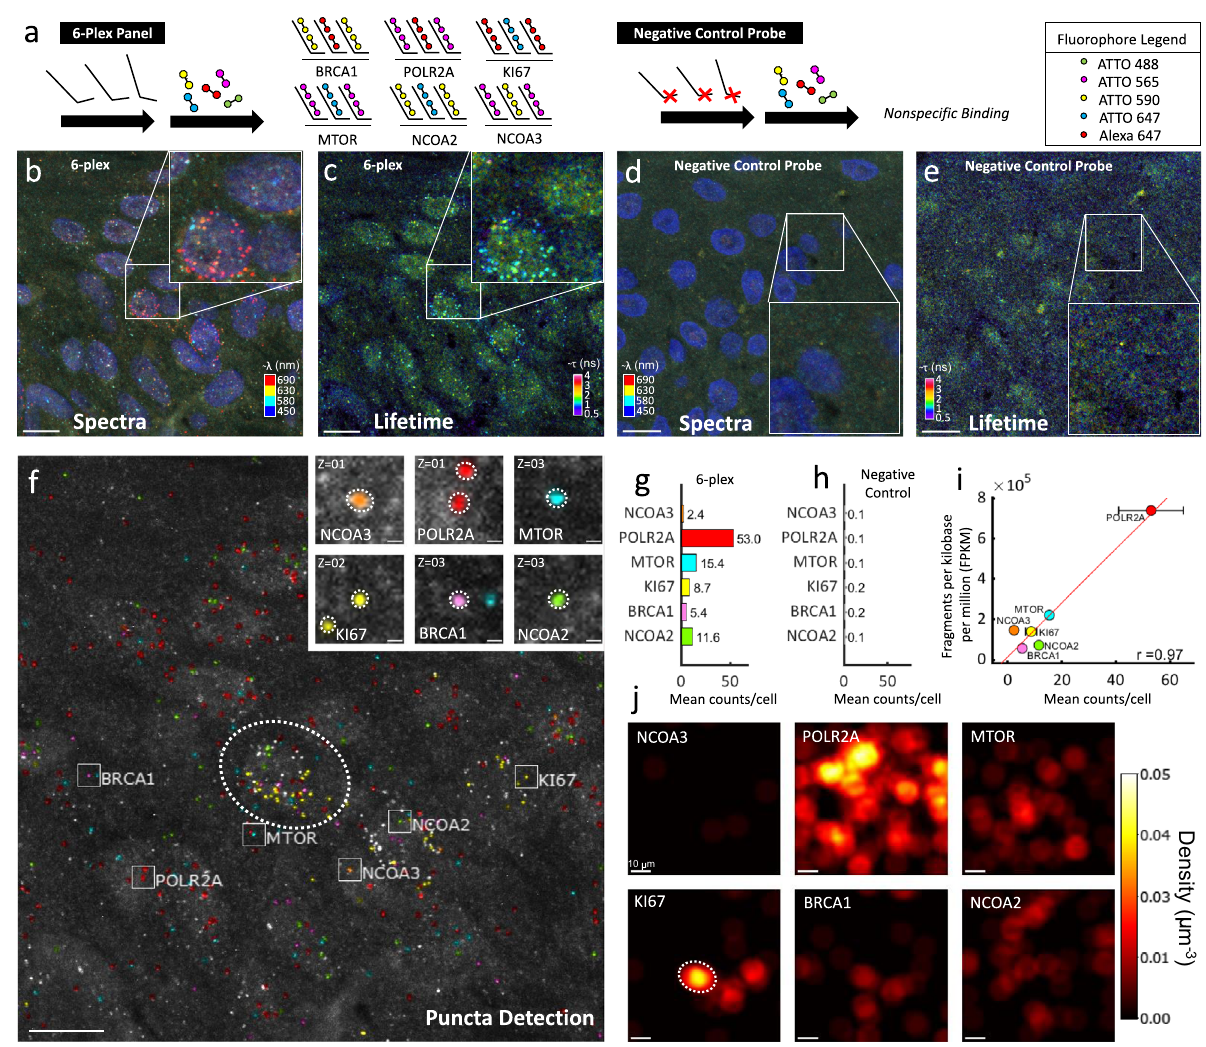
Fig. 5 Multiplexed mRNA detection in epidermis region of human skin melanoma FFPE tissue. a 6 different types of gene transcripts were labeled with primary probes followed by respective and complementary fl uorescent secondary probes. Each transcript was labeled with a combination of two different fl uorophores for six combinations. Negative control probes targeting transcripts not present in the sample were used with their respective secondary fl uorophore probes. b Spectral image (max-projection in z) of a fi eld of view of the labeled 6-plex sample (three channel pseudo coloring). c Lifetime image (max-projection in z) of a fi eld of view of the labeled 6-plex sample (phasor projection on universal circle pseudo coloring). d Spectral image of the labeled negative control probe sample is depicted. e Lifetime image of the labeled negative control probe sample. f Final puncta detection of the 6-plex fi eld of view after being processed in our analysis software showing highlighted example puncta of each target (insets, right). g Mean puncta counts per cell of transcripts for each gene in the 6-plex sample ( n = 2 experimental replicates, 174 cells). h Puncta count for the negative control probe sample ( n = 2 experimental replicates, 375 cells). i Correlation of detected puncta (mRNA puncta count) vs. bulk sequencing (fragments per kilobase per million) is shown for each target. j Transcript density in the fi eld of view for each of the expressed genes reveals clustering of speci fi c genes, as an example KI67 appears highly expressed in three cells, one of them marked with a dotted ellipse that corresponds to location in f ). Scale bars 10 µ m in large images and 1 µ m in insets. Source data are provided as a Source Data fi spectral and lifetime images of the corresponding negative probe sample also in the epidermis region. Figure 5f depicts the pseudo- colored puncta which were successfully classi fi ed and identi fi ed as their assigned mRNA markers. A representative inset image for each marker and its targeted detection is provided on the right. We observed that a population of puncta consisting of nonspeci fi c, auto fl uorescent, or unknown sample artifacts rejected from analysis, (1,100) or 37.5% of the total detected puncta (2,934). In addition to this group, MOSAICA rejected a small group of puncta that emitted fl uorescence in multiple spectral channels (62). This fraction (2.1%) is in concordance with the optical crowding range (2.0 – 6.6%) that our simulations and models predict (Supplementary Fig. 4). With conventional intensity-based measurements and analysis, both